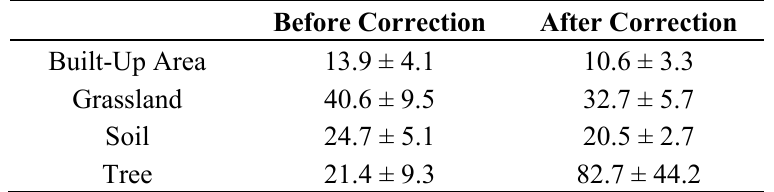
Table 5. Mean and standard deviation of the intensity data for different land cover classes before and after radiometric correction.